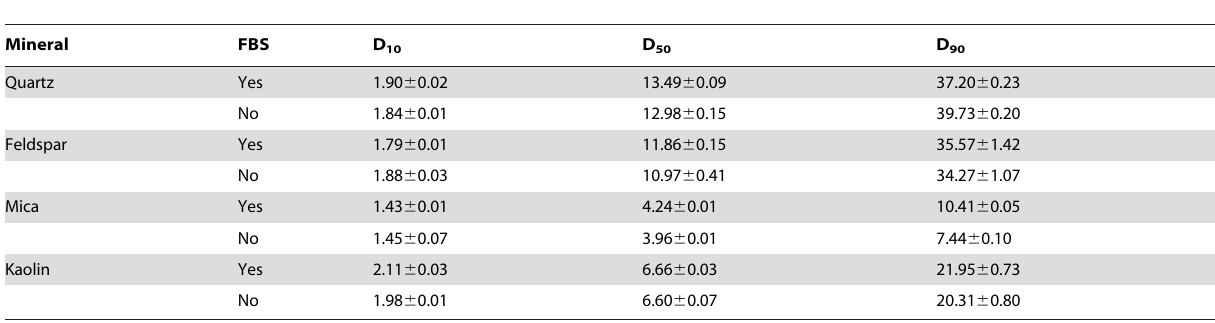
Table 1. Particle size characterization of the investigated particle samples.